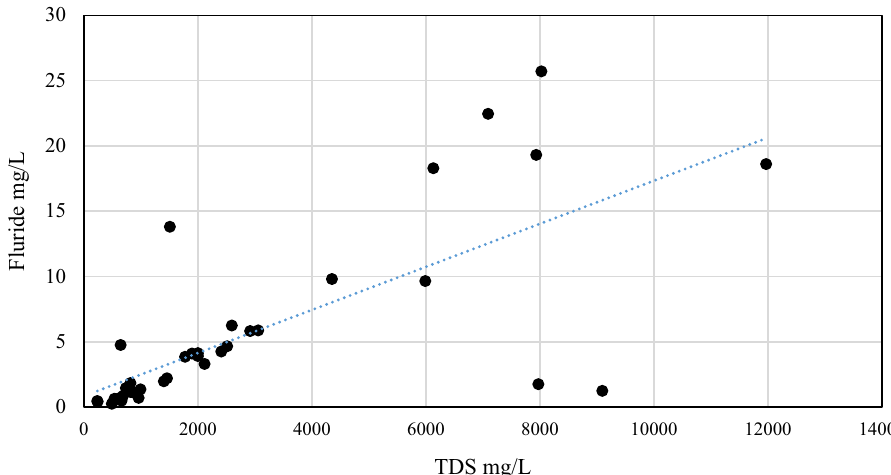
Fig. 3 Scatter diagram of fluo- ride versus